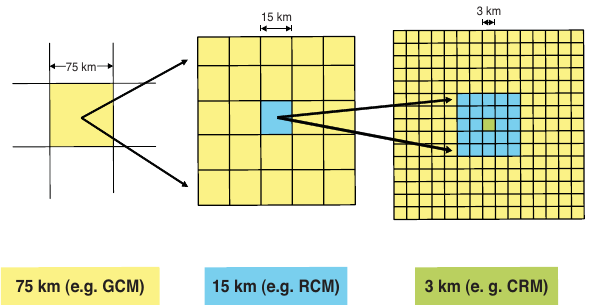
Fig. 1. Conceptual subdivision of a coarse grid cell from the 75-km grid into smaller grid points for the finer grids. Each 75-km grid cell is subdivided into 25 15-km grid cells. Each of the 15-km grid cells are further refined into 25 3-km grid cells for a total of 625 3-km grid cells per 75-km